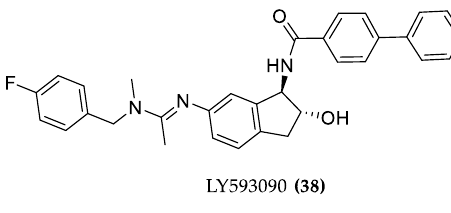
Figure 16. Structure of LY593093.